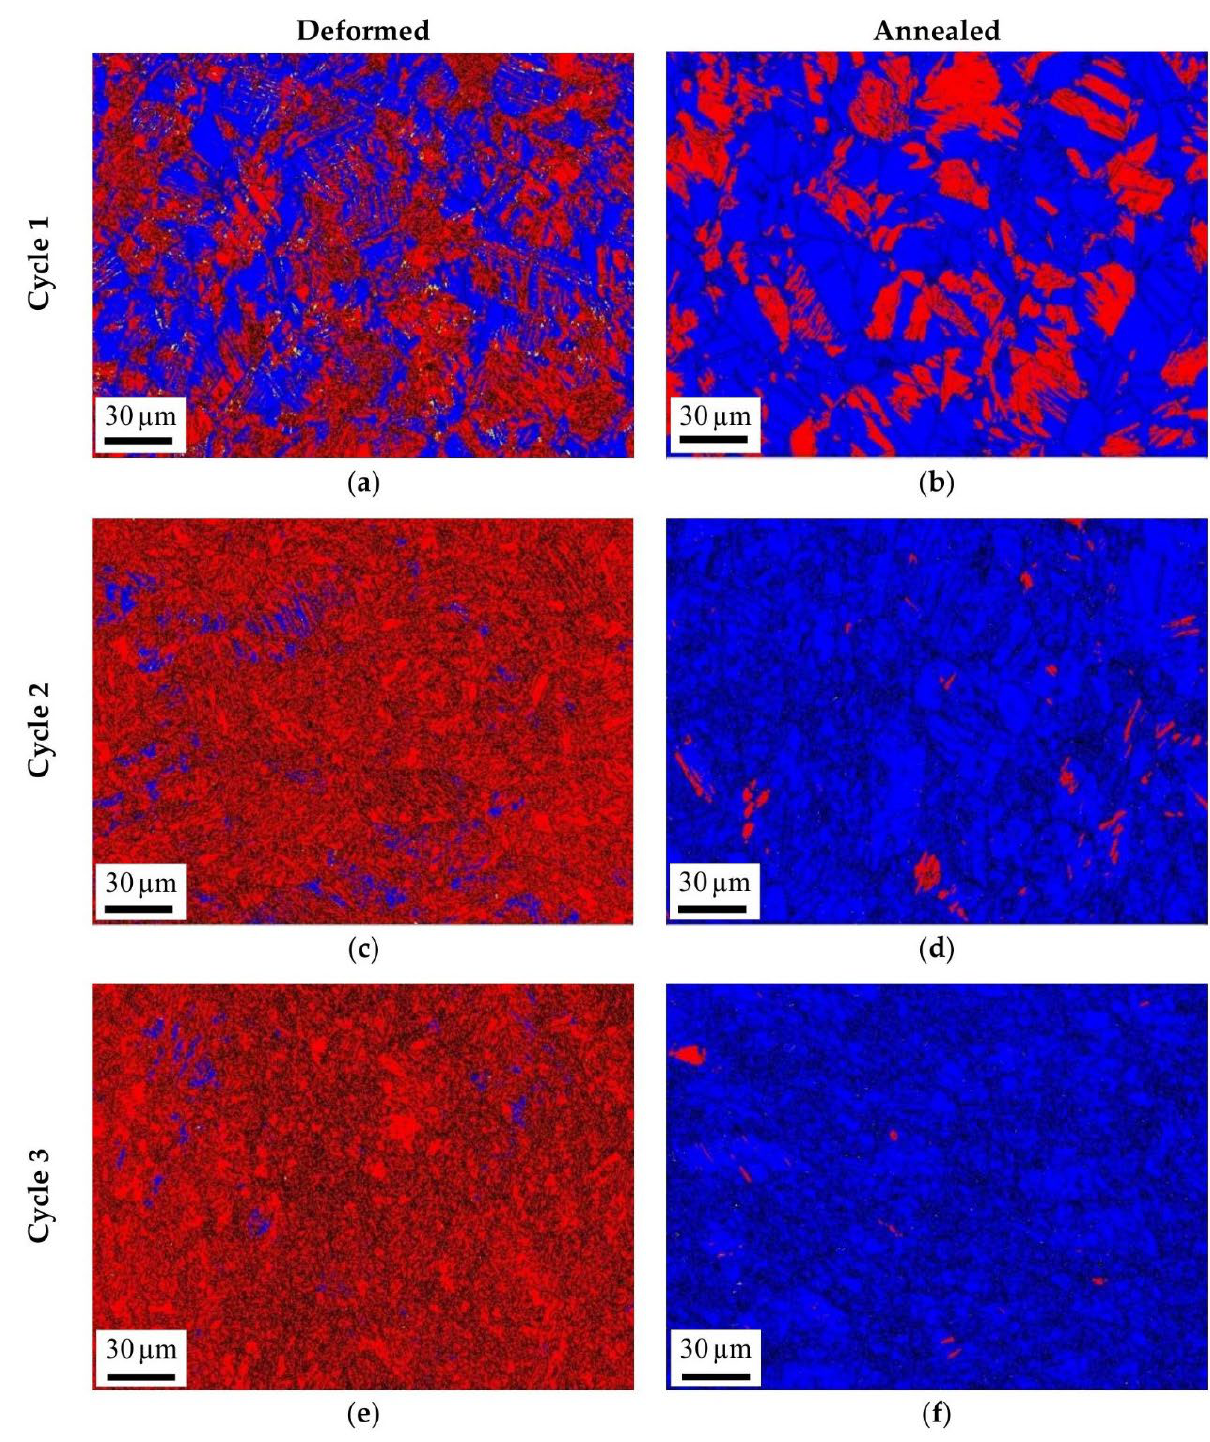
Figure 3. Phase maps for TMP samples processed using three cycles and strain of 0.15: ( a , b ) Cycle 1, ( c , d ) Cycle 2, and ( e , f ) Cycle 3. Austenite is blue, α′ - martensite is red, and ε -martensite is yellow.